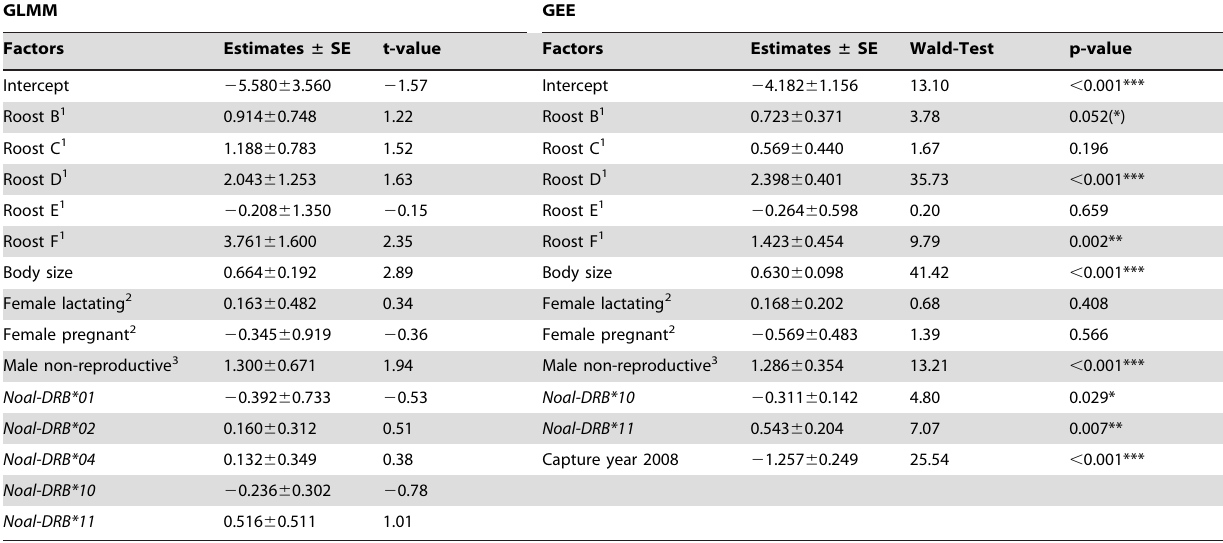
Table 2. Tick infestation in N. albiventris .